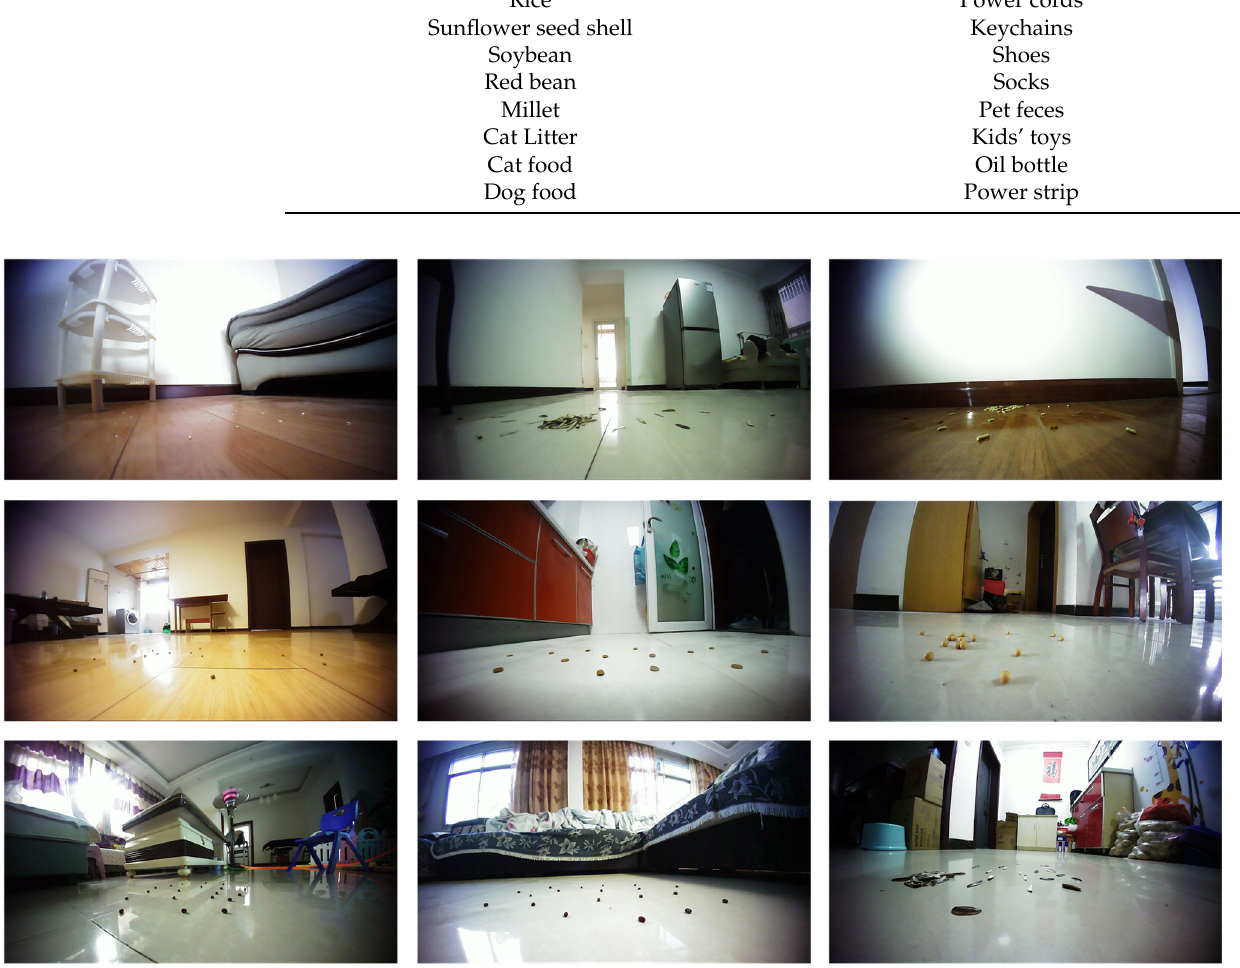
Figure 3. Several images of indoor cleanable litters such as rice, sunflower seed shell, soybean, red bean, millet, cat litter, and cat food.